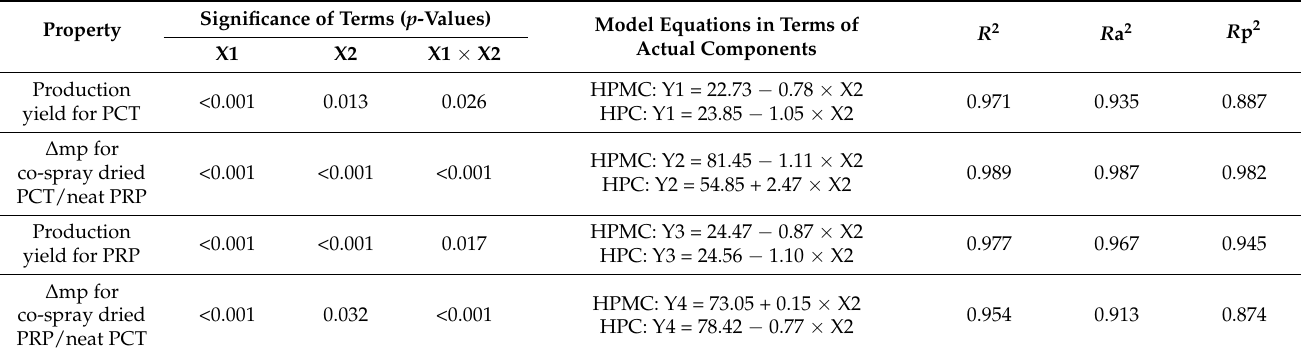
Table 3. Statistical equations derived from ANOVA for yield of spray drying of each drug and melting point difference in drugs ( ∆ mp) in mixtures of co-spray dried/neat drugs as a function of polymer type (X1) and polymer content (X2). Significance of Terms ( p -Values) Property Production yield for PCT